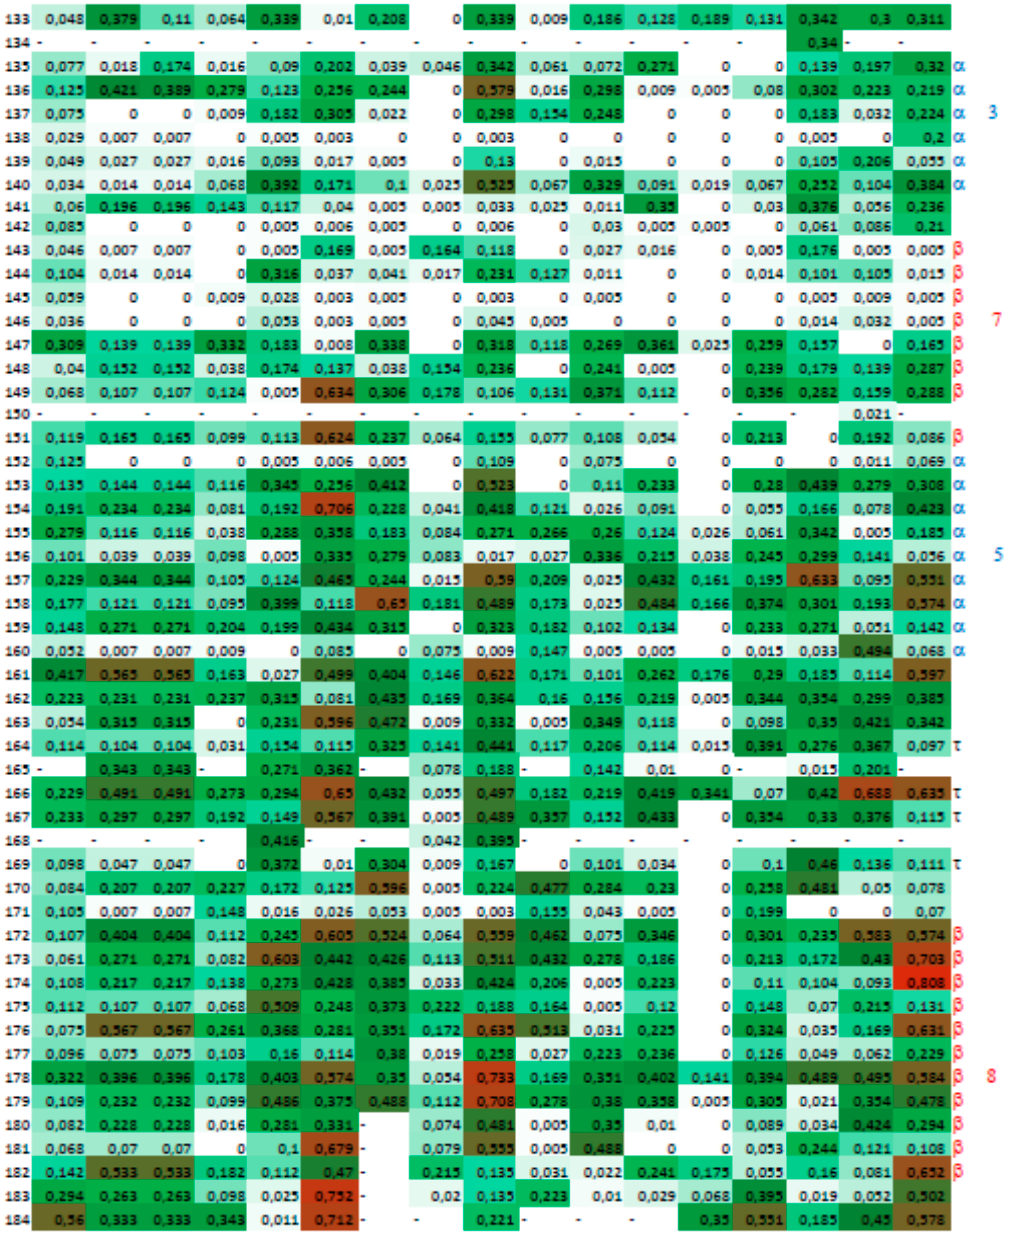
Figure 6. Heat-map of the cyclophilins encoded in various genomes. Vertical sequence alignments (Figure S7A and vertical MSA of the cyclophilins, Figure S7B, supplementary materials) could be useful for finding some correlations between the first column that has the numbering taken from Figures 1 and 2, respectively. The order of vertical lines is as described in Figure 2. We used the names of genes coding each of the analyzed paralogue of human cyclophilins and its orthologues encoded in the genomes of disparate